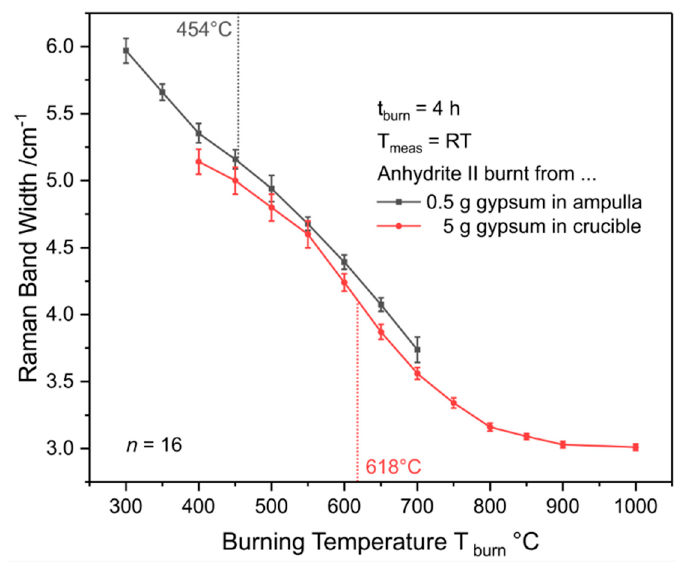
Figure 18. Full widths at half maximum of the ν 1 mode of anhydrite II, which was burnt from gypsum at different temperatures—either in glass ampullae or open crucibles—in a laboratory furnace. The measurements were performed after cooling the kiln run to room temperature.